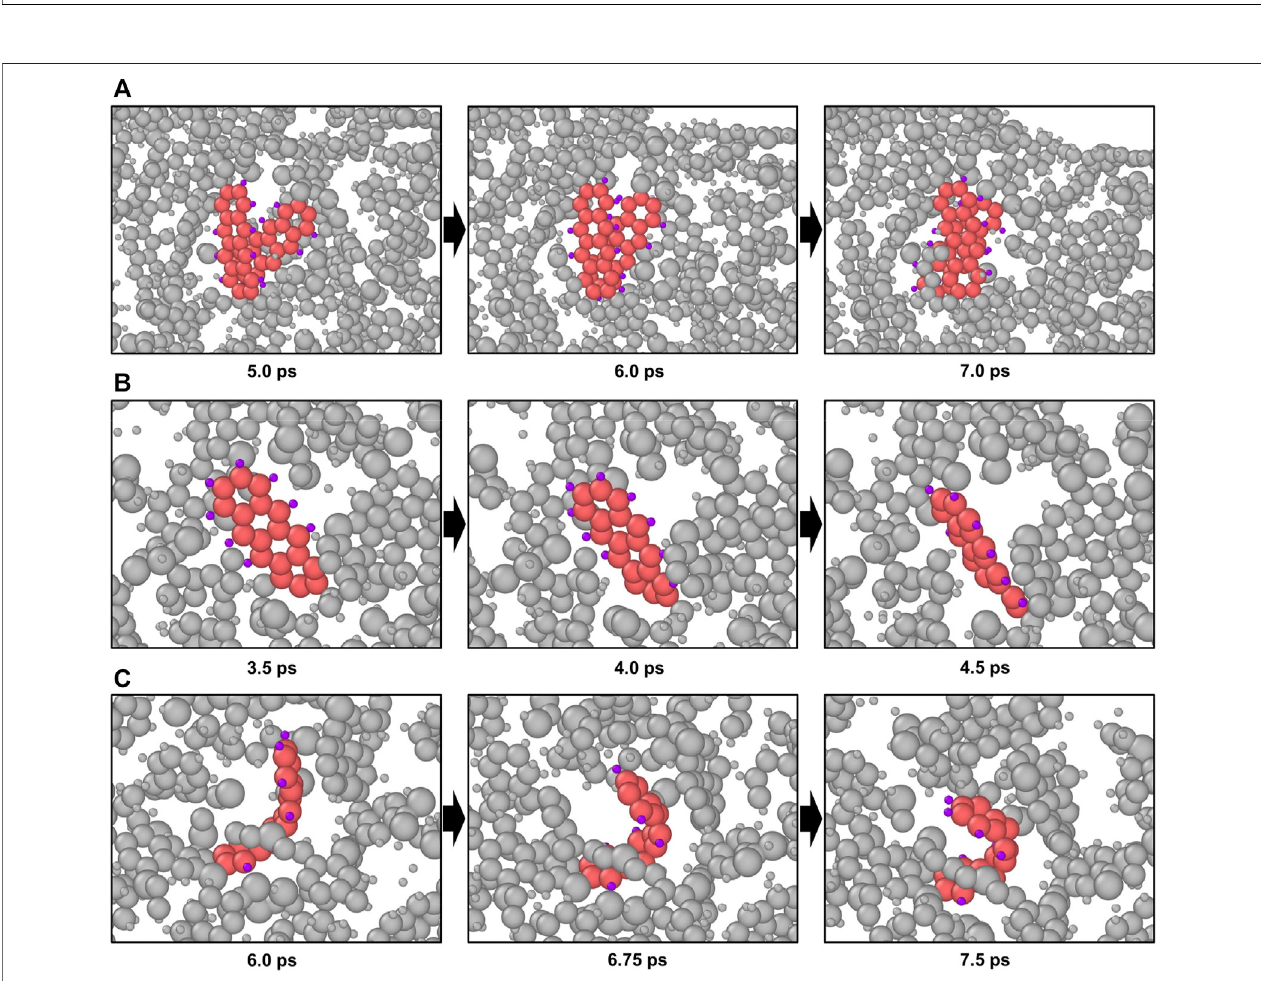
Frontiers in Earth Science |